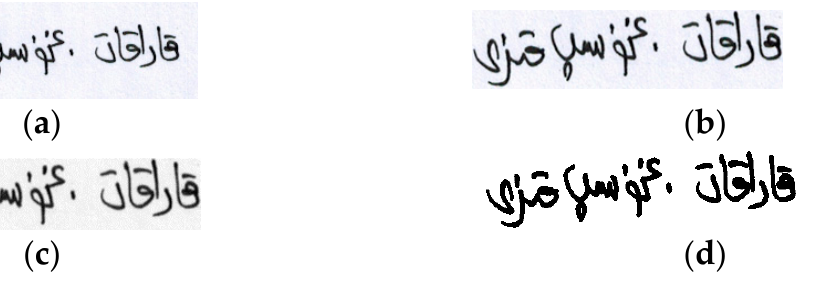
Figure 3. Preprocessing signature image: ( a ) initial image; ( b )normalization image; ( c ) denoise image; ( d ) binary image.